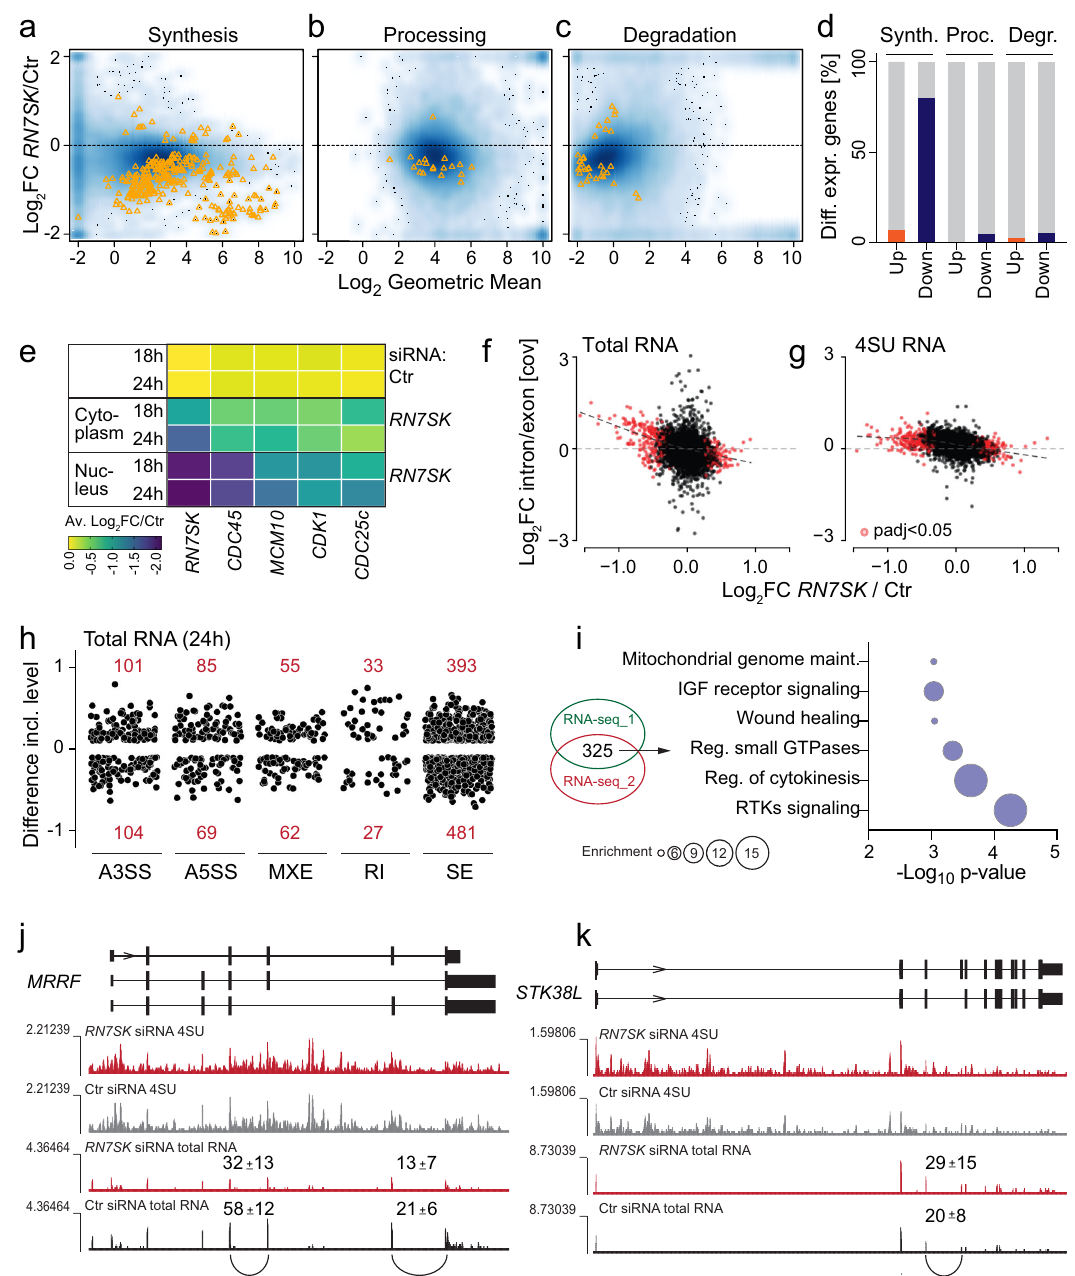
Fig. 6 Loss of RN7SK primarily affects RNA synthesis. a – c Density scatter plots (darker colours for higher density) of changes in the absence of RN7SK versus time points (0 and 24 h and 10 min RNA labelling time). Shown are changes in RNA levels caused by differences in RNA synthesis ( a ), processing ( b ), and mature mRNA degradation ( c ). Each yellow triangle is one gene. d Percent of differentially expressed genes shown in ( a – c ). e Average (Av.) log 2 fold-change (FC) of RNA levels of the indicated genes in the cytoplasm or nucleus after 18 and 24 hours (h) knock-down of RN7SK measured by RT-qPCR. ( n = 4 transfections). f , g Correlation of log 2 (Fc) expression and log 2 (intron/exon coverage) in total ( f ) or 4SU ( g ) RNA seq datasets 24 h after RN7SK siRNA transfection. h Splicing differences in total RNA 24 h after RN7SK -depletion (splicing FDR > 0.05; inclusion difference >0.1 or < − 0.1). A3SS: alternative 3 ’ splice site; A5SS: alternative 5 ’ splice site; MXE: mutual exclusive exon; RI: intron retention; SE: exon skipping. i Gene Ontology analysis using ( j ) or up- ( k ) regulation of the RNA shown as UCSC genome. Source data are provided as a Source Data fi